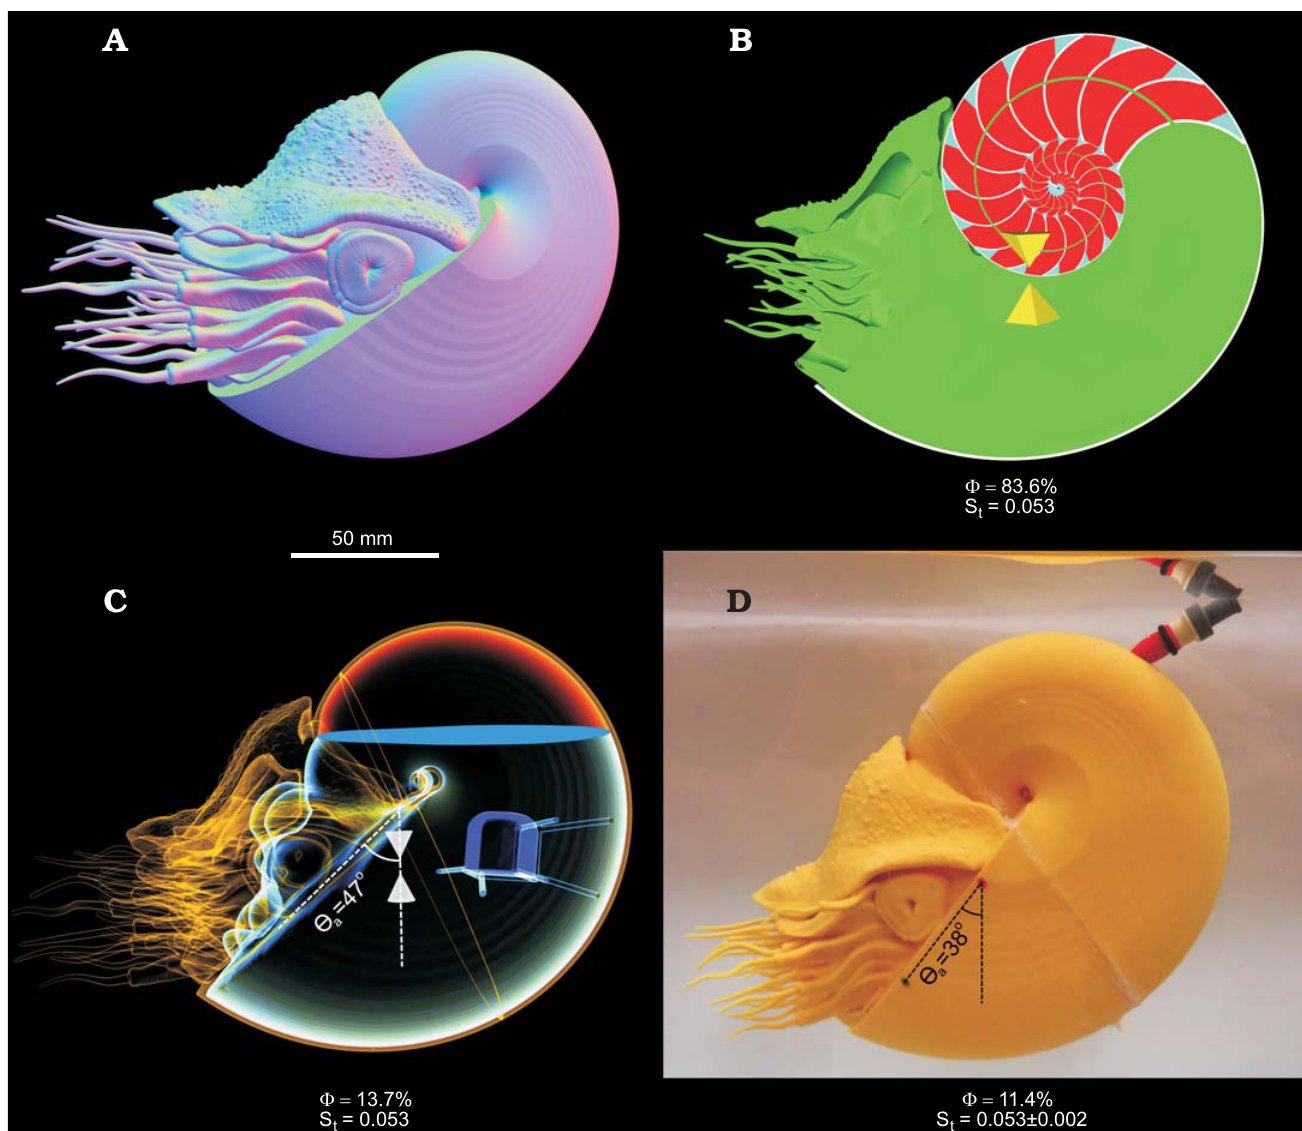
Fig. 7. Virtual and physical hydrostatic models of Nautilus pompilius with computed percentage of the phragmocone emptied for neutral buoyancy ( Φ ) and hydrostatic stability (S t ). The tip of the up-side-down pyramid = center of buoyancy. The tip of the right-side-up pyramid = total center of mass. A . External view of the virtual model. B . Medial section of the virtual model with each component of unique density (green, soft body; red, cameral gas; blue, cameral liquid; grey, shell). C . Modified virtual model with simplified internal geometry and bismuth counterweight (yellow, PLA plastic; red, air; blue, liquid; purple, bismuth counterweight). D . Neutrally-buoyant, 3D printed model. The differences in Φ and the apertural angle ( θ a ) are a result of the mass discrepancy (Table 5) and irregular geometry of the balloon. The error in S t was computed assuming that the total mass discrepancy was distributed in the positive or negative angle at rest is rotated from about 5° from the vertical axis in the dorsal direction when compared to the straight, vertical models.